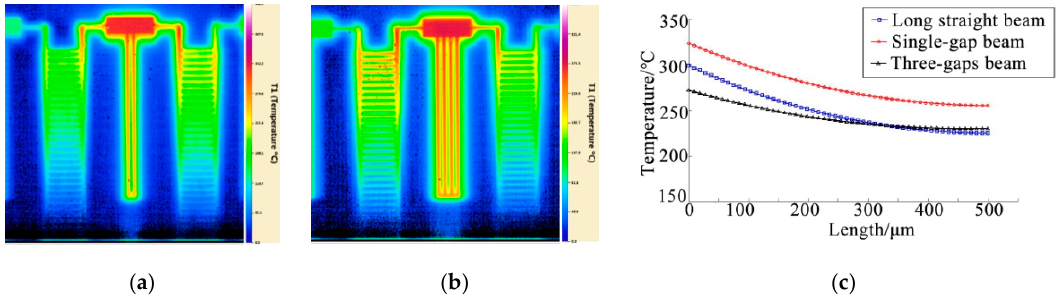
Figure 7. Measured temperature field and fitting curve of the gap structures: ( a ) Temperature field of a single-gap structure; ( b ) temperature field of a three-gap structure; ( c ) fitting curve of the gap heat transfer parameters.